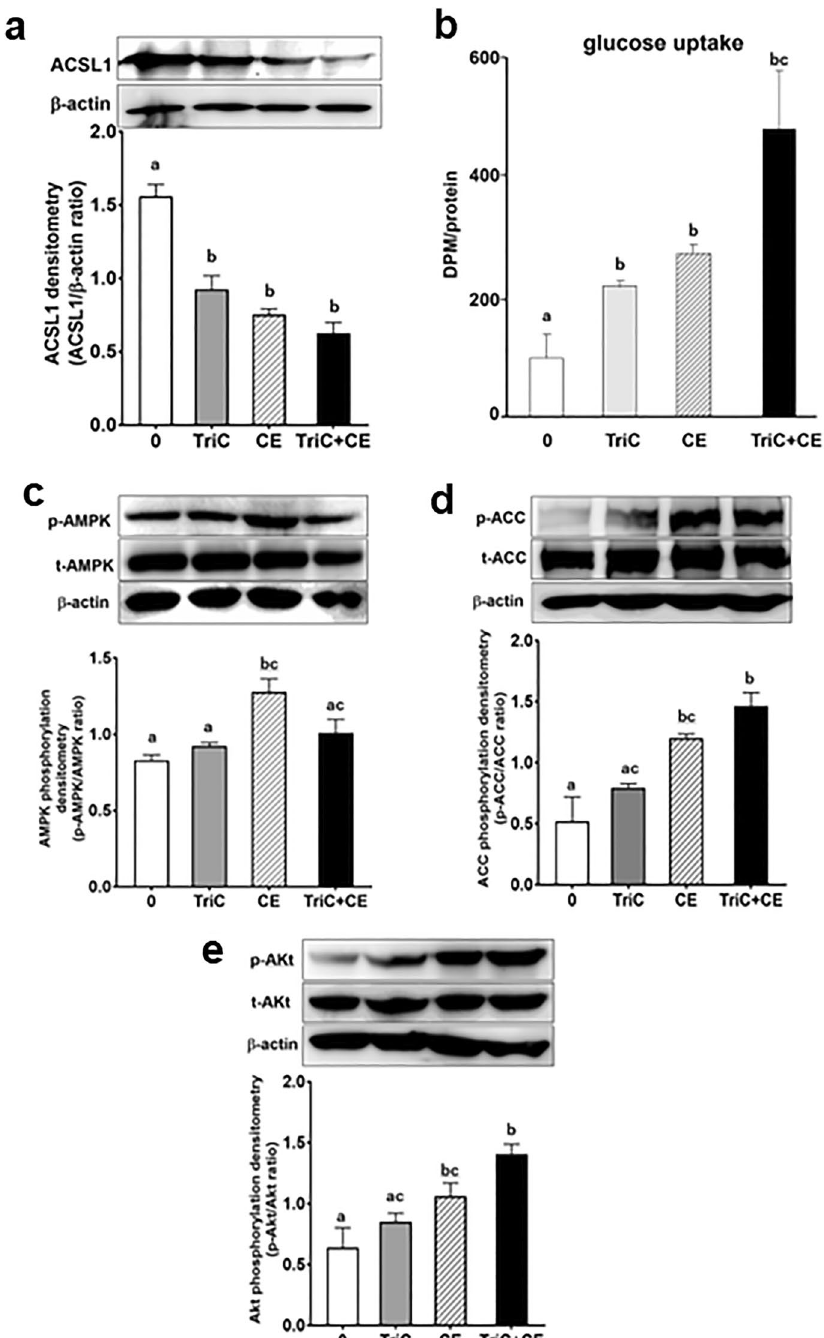
Figure 4. Triacsin C (TriC), an inhibitor of ACSL1, and Cinnamon extract (CE), regulate glucose uptake and ACC phosphorylation in 3T3-L1 adipocytes. 3T3-L1 adipocytes were serum-starved for 8 h in DMEM and then challenged with 10 µM TriC for 45 min or with 30 µg/mL of CE for 30 min. ( a ) ACSL1 expression levels were measured via western blotting. ( b ) The uptake of 2-deoxyglucose by the cells was assayed, as described in the Materials and Methods section. ( c – e ) The levels of AMPK, ACC, and Akt phosphorylation were measured via western blotting using total AMPK, ACC, and Akt as loading controls. Each value represents the mean ± SD of three different experiments (n = 3/group). Alphabet letters indicate intergroup comparisons. Different alphabet indicate statistically significant differences among groups (P<0.05). The image is a cropped blot and the full- length images of the western blot for the three experiments are provided in Supplementary Fig. S4 a–d. In Fig. S4d images, different parts of the same membrane were cut out and reacted with different antibodies. The cutouts are clearly distinguished using yellow separator